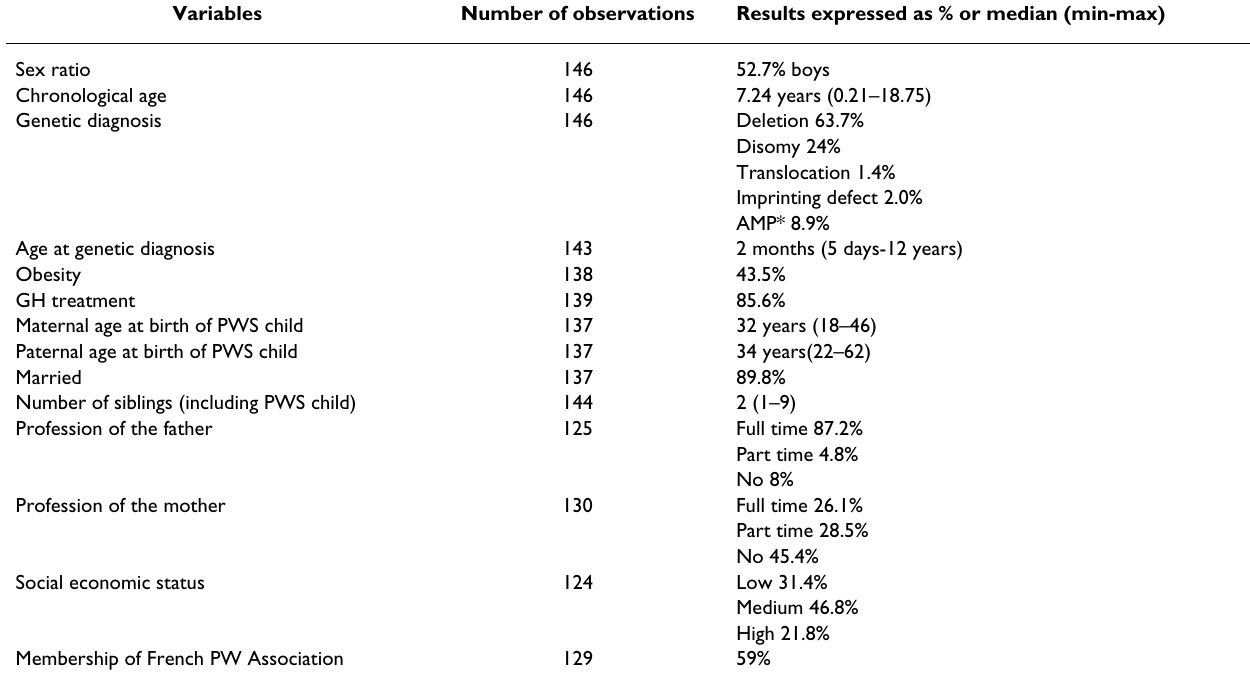
Table 3: Characteristics of the population at inclusion